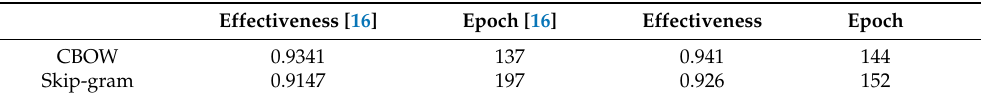
Table 6. Comparison of classification performance results for CBOW and Skip-gram methods with the work